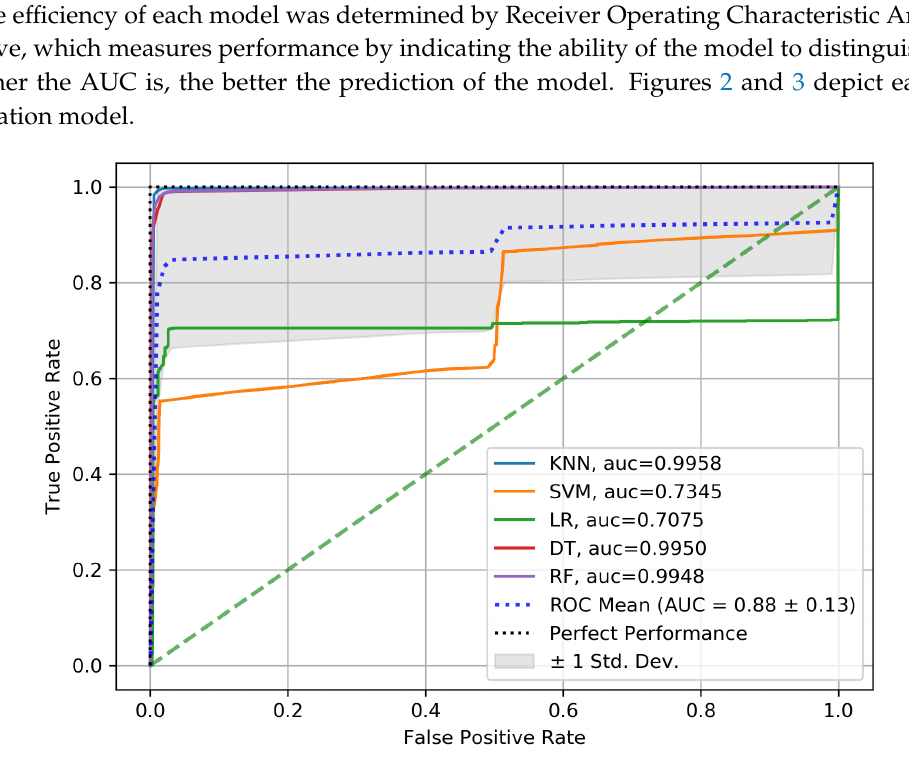
Figure 2. Receiver Operating Characteristic (ROC) for balanced subset